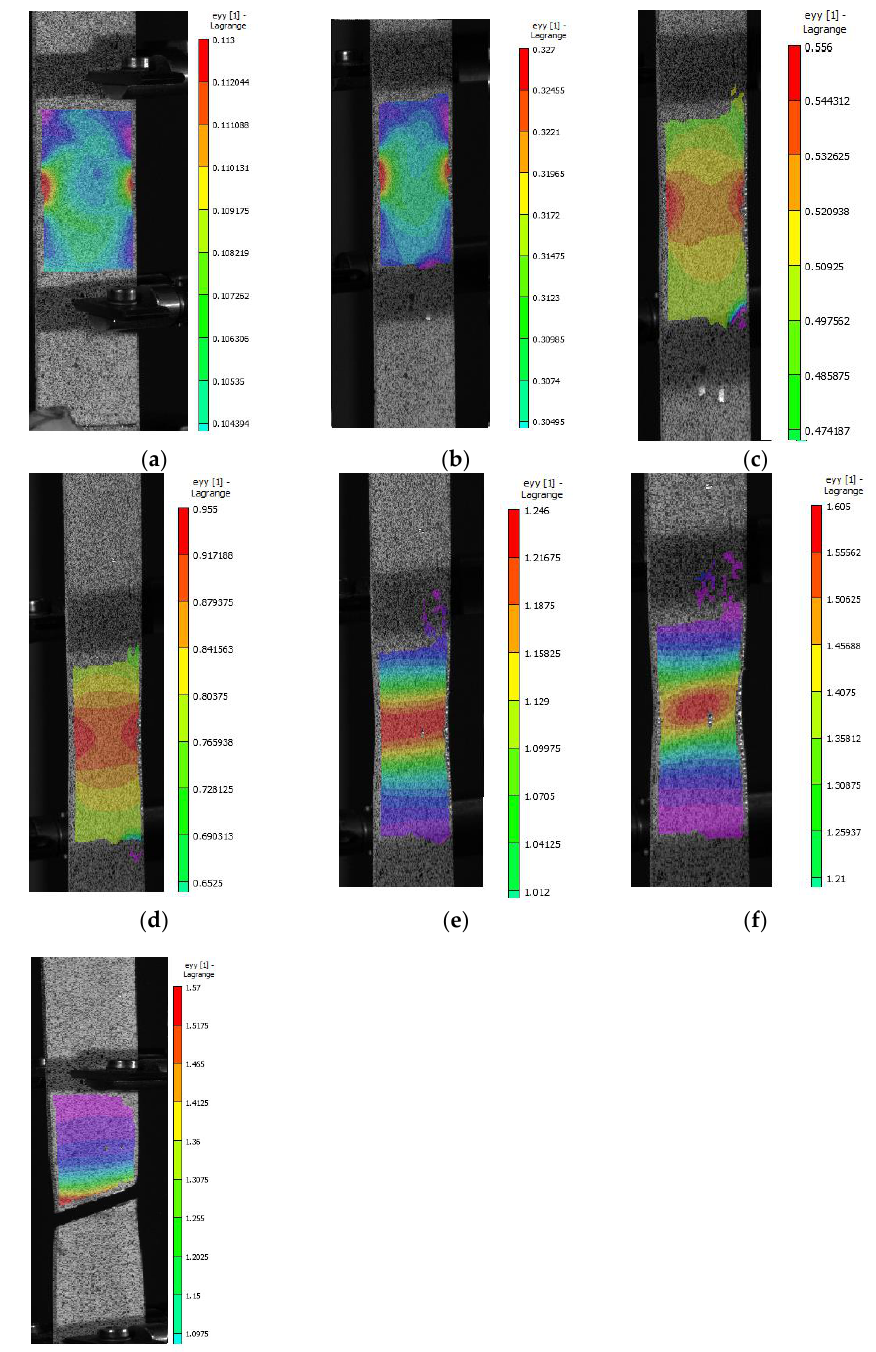
Figure 3. Strain contour plot of an SS304 steel sheet at the ultimate load with different strain legends. Figure 3 represent contour of test sample obtained from DIC. ( a ) 𝜀 𝑦𝑦 distribution at time 0s. ( b ) 𝜀 𝑦𝑦 distribution at time 30s. ( c ) 𝜀 𝑦𝑦 distribution at time 60s. ( d ) 𝜀 𝑦𝑦 distribution at time 90s. ( e ) 𝜀 𝑦𝑦 distribution at time 120s. ( f ) 𝜀 𝑦𝑦 distribution at time 150s. ( g ) 𝜀 𝑦𝑦 distribution at time 180s.